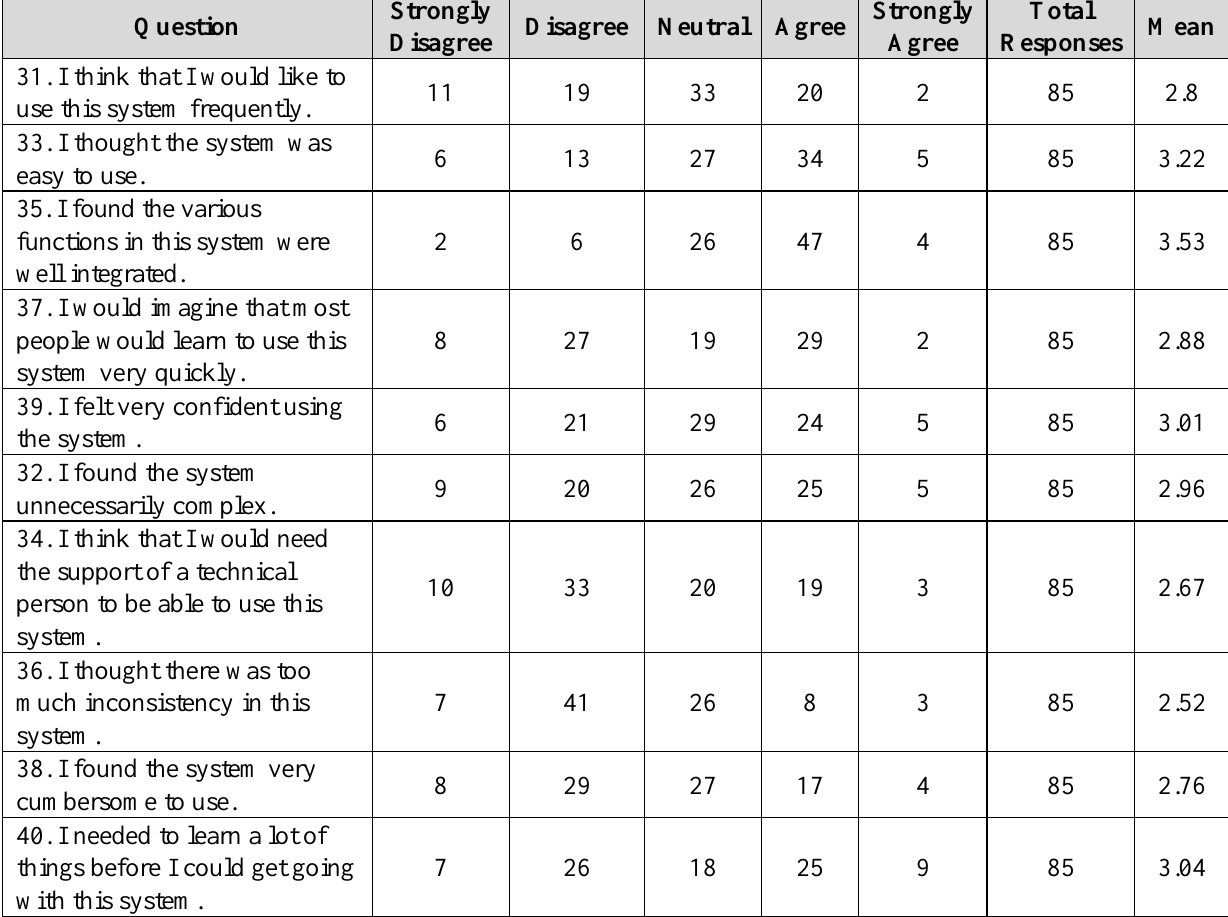
Strongly Disagree Neutral Agree Disagree